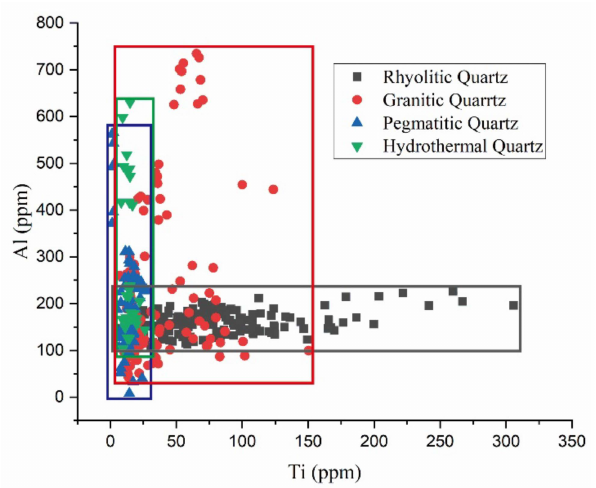
Figure 11. Demonstration of the relationship between Al and Ti in different types of